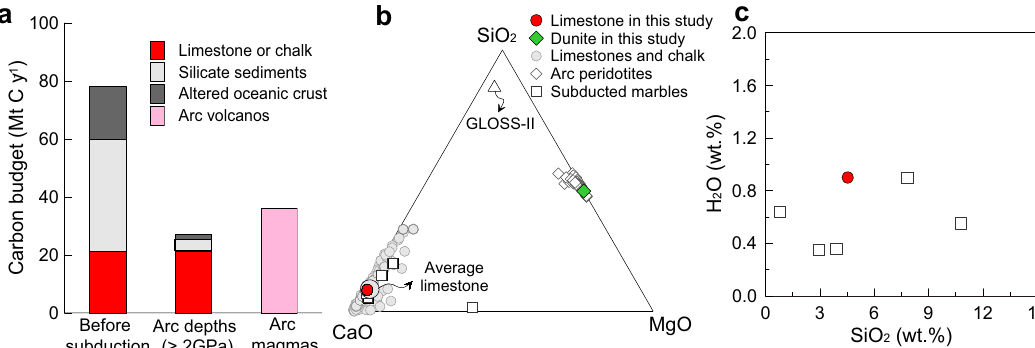
Fig. 1 Subduction carbon fl uxes and chemical compositions of starting materials. a The constructed carbon budget in global subduction zones at forearc depths 3,8 and subarc depths 6 . The carbon emission fl ux in arc volcanos is shown for comparison 4 . b The compositions of the limestone and dunite used as the starting materials in this study compared to natural marine limestones and arc peridotites (including harzburgites and dunites). The global weighted average composition of subducted sediments (GLOSS-II) is shown for comporison 65 . Data sources of natural marine limestones and arc peridotites are provided in the supplementary information. c The comparison of the water content of the limestone used as the starting material with marbles from the S. W. Tianshan UHP subduction zone (>2.1 GPa) 32